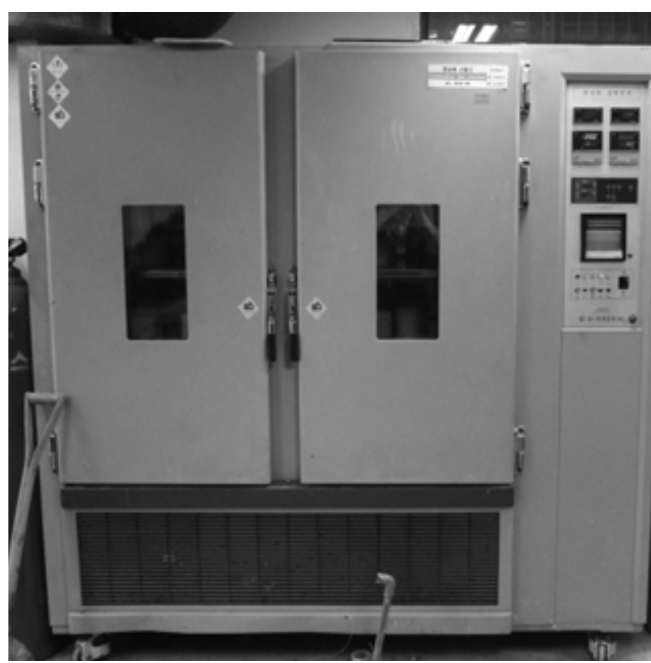
Figure 3. Carbonation test chamber.